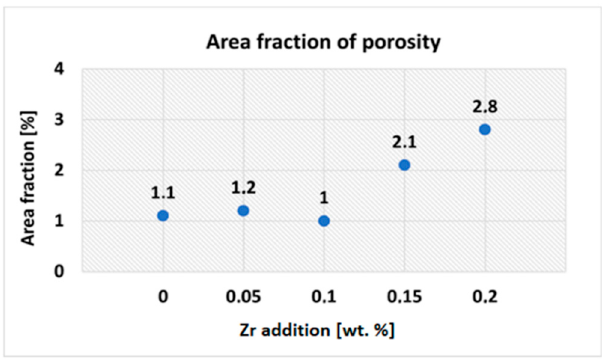
Figure 7. Area fraction of porosity depending on Zr addition .